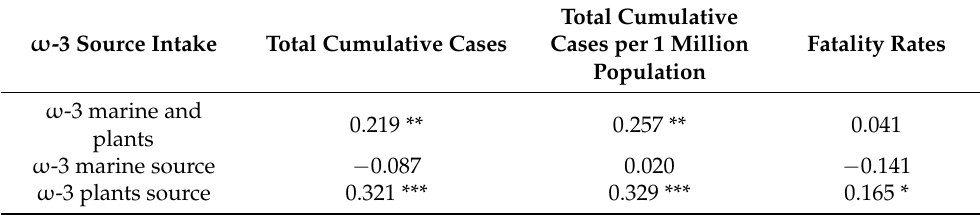
Table 2. Correlation matrix ω -3 PUFA intake and epidemiological figures by COVID-19 1